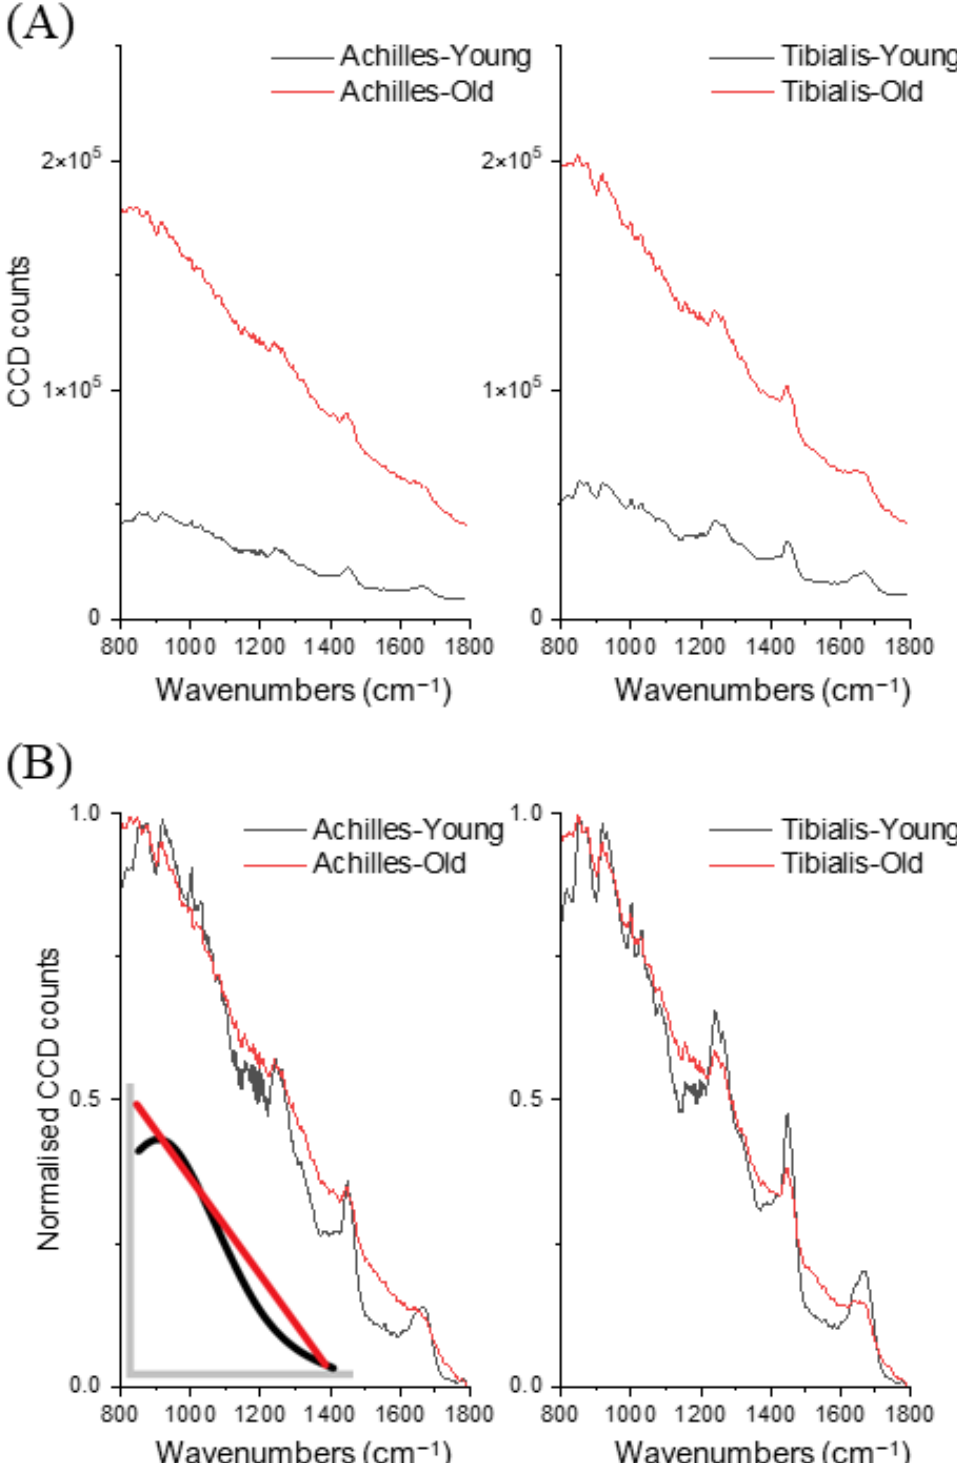
Figure 1. Averaged ( A ) and normalised ( B ) raw CCD counts (n = 160, 40 per group) between young and old Achilles tendons and tibialis anterior tendons. Inset: representative figure of different background shapes between young (black) and old (red) tendons. After fluorescence background removal, the underlying Raman spectra were pooled and underwent principal component analysis (PCA). The Achilles tendon and tibialis